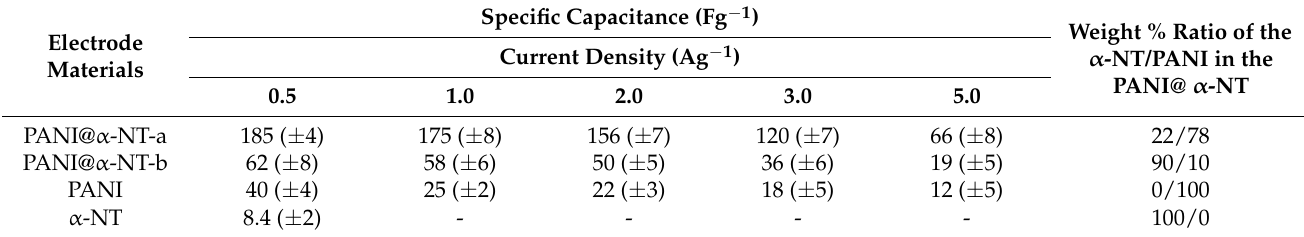
Table 1. Specific capacitance of PANI@ α -NTs, α -NTs and PANI at different current densities.